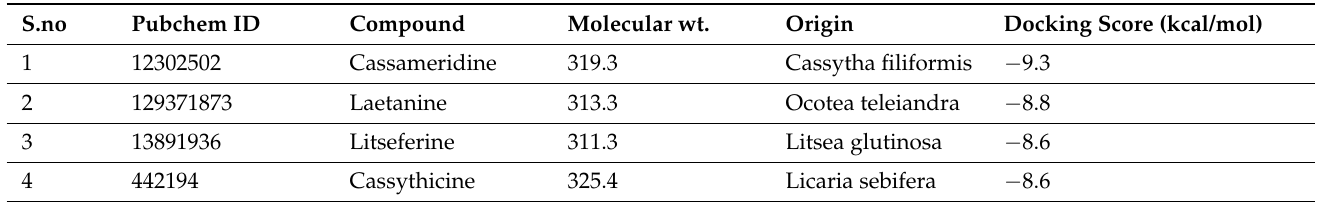
Table 1. The structure-based virtual screening process obtained names and characteristics of the selected phytochemical compounds against the SARS-CoV-2 M pro receptor from the collected phyto- chemical compounds.